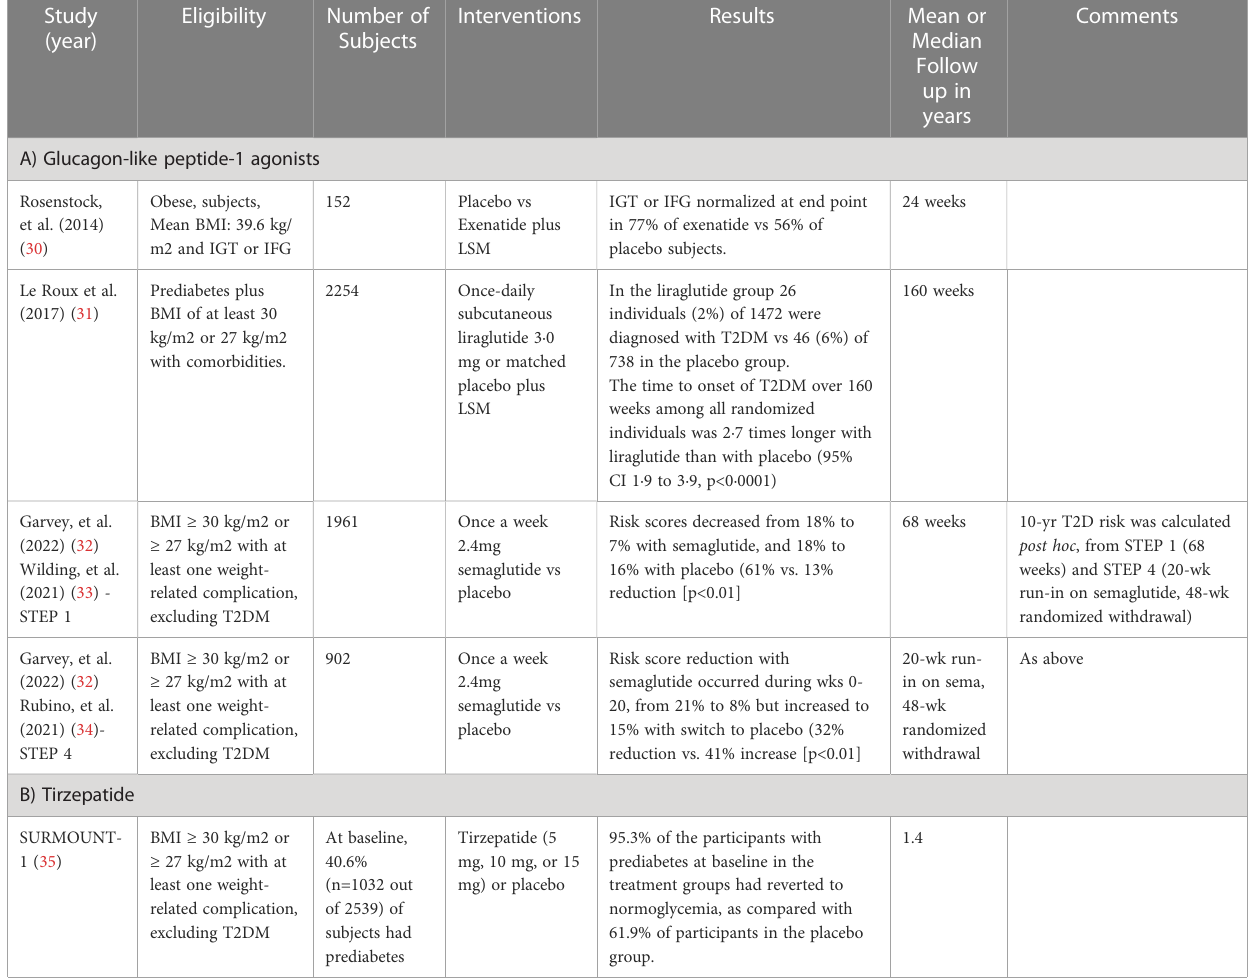
diagnosed with T2DM vs 46 (6%) of 738 in the placebo